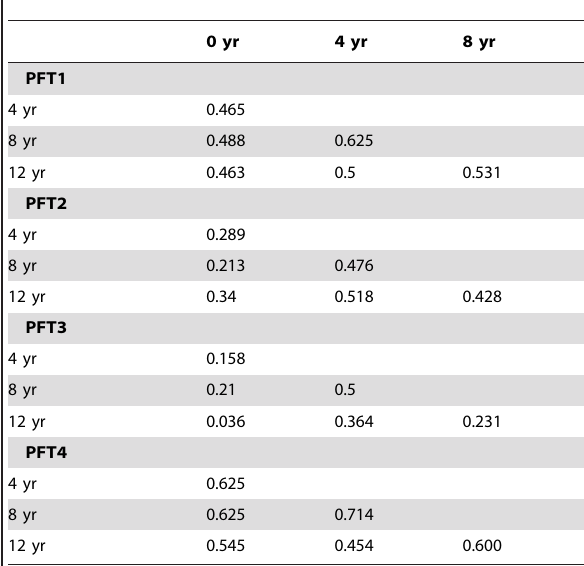
Table 5. Jaccard’s similarity coefficients (ISJ) of plant functional types between different regeneration stages after pine wilt disease indicated the species turnover rates of PFTs.